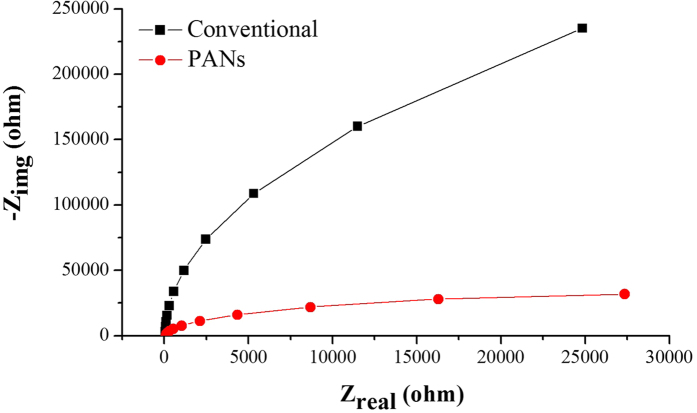
Fitted Nyquist plots corresponding to electrochemical impedance spectra (EIS) for conventional and porous acupuncture needles.